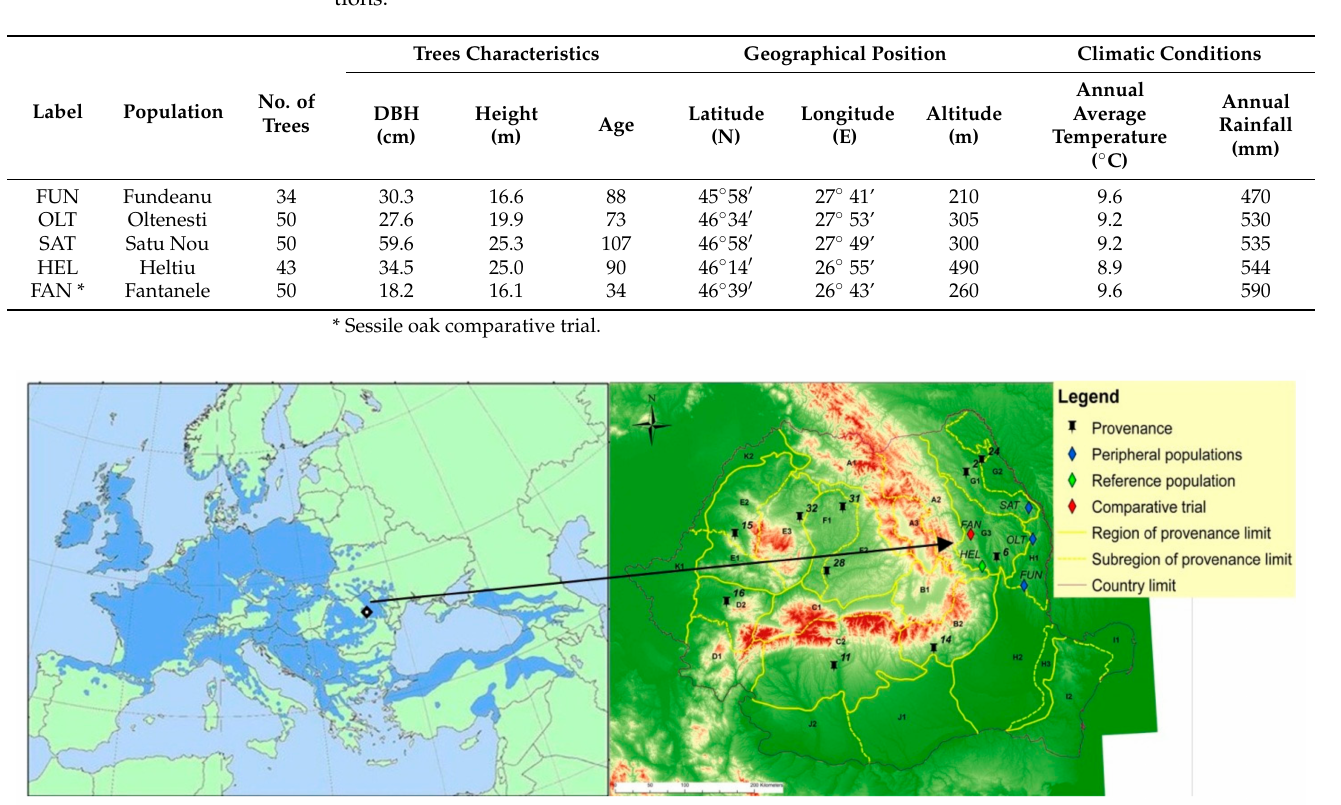
Table 1. Geographic location, sample size, and climate conditions of the sampled sessile oak popula- tions.